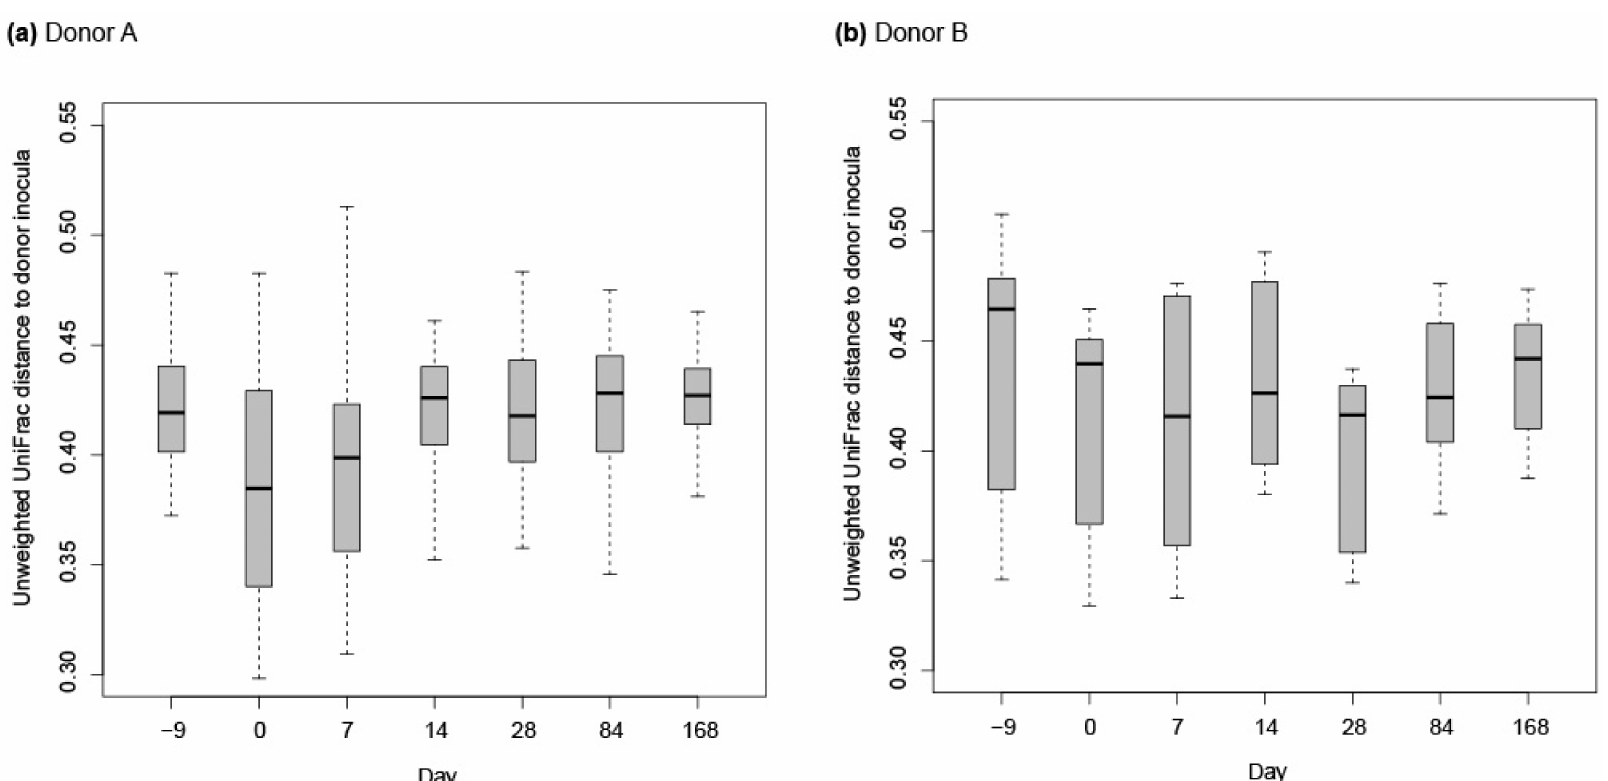
Figure 11. Boxplots are shown by donor animal (i.e., A or B) for the similarity of FFW horse faecal microbiota with the donor inocula over time using unweighted UniFrac. All pairwise distances of a FFW horse faecal microbiota sample at one interval with all donor inoculant samples was used to generate the box plots (e.g., FFW horse faecal microbiota sample d –9 was compared with donor inoculant samples D-4, D-3, D-2, D-1, D0; FFW horse faecal microbiota sample d 0 was then compared with donor inoculant samples D-4, D-3, D-2, D-1, D0 etc.). Boxes show the 25th and 75th percentiles with the median represented by a horizontal line. Whiskers show the data